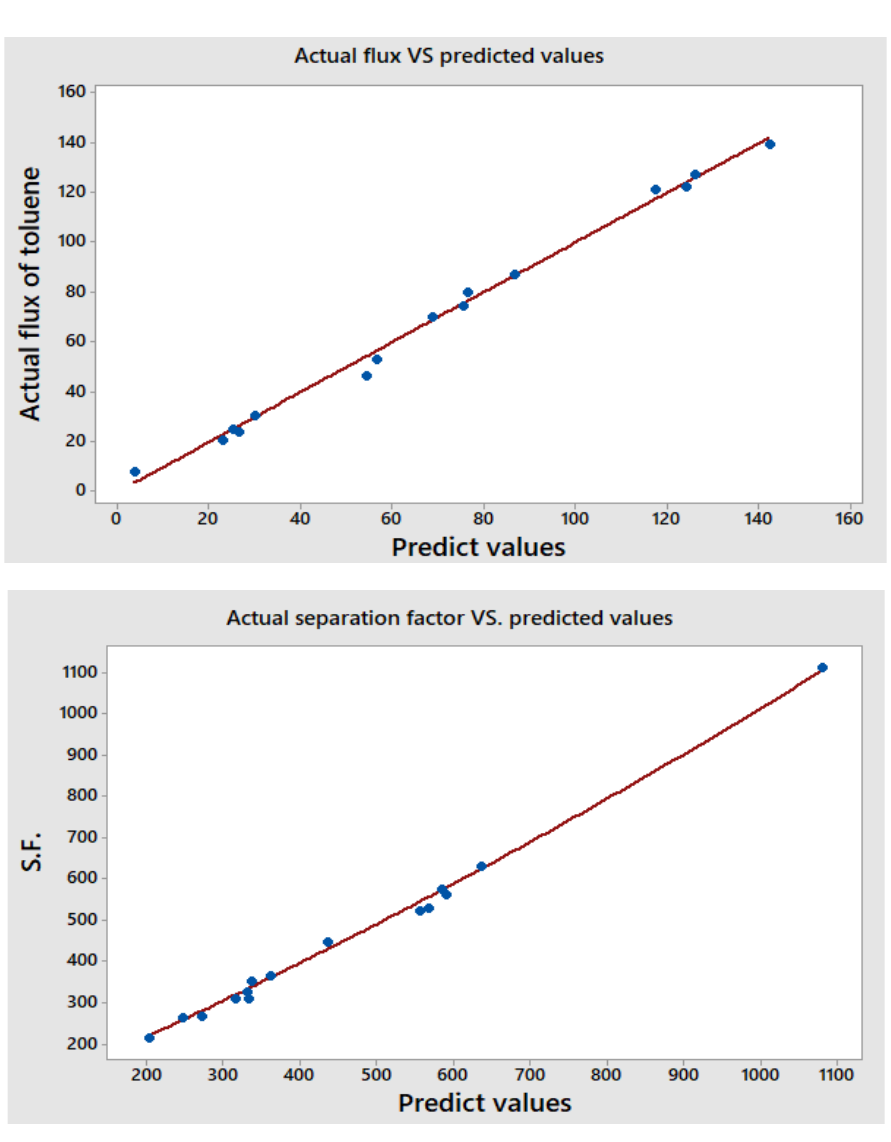
Figure 5. The relationship between actual and predicted toluene flux and separation factor (S.F.).